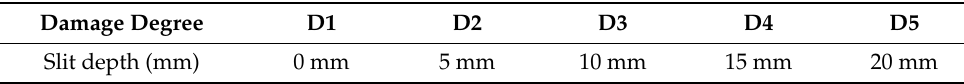
Figure 4. Location of the impact point and the simulated damage. Table 1. Degree of damage to refractory materials during the percussions.